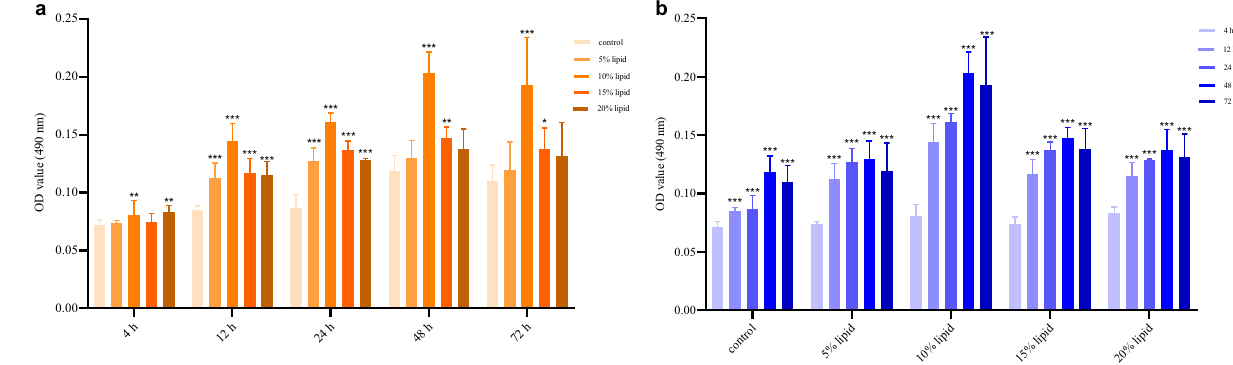
Figure 1. Effect of lipid emulsions on microbial adhesion and mixed-species BF biomass. Compared with the control group at the same time, * P < 0.05, ** P < 0.01, *** P < 0.001 ( a ). Compared with the 4 h at the